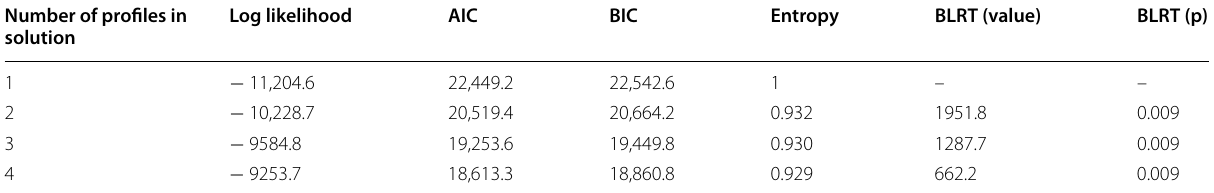
Table 4 Latent profile analysis fit statistics for 791 Classes Number of profiles in